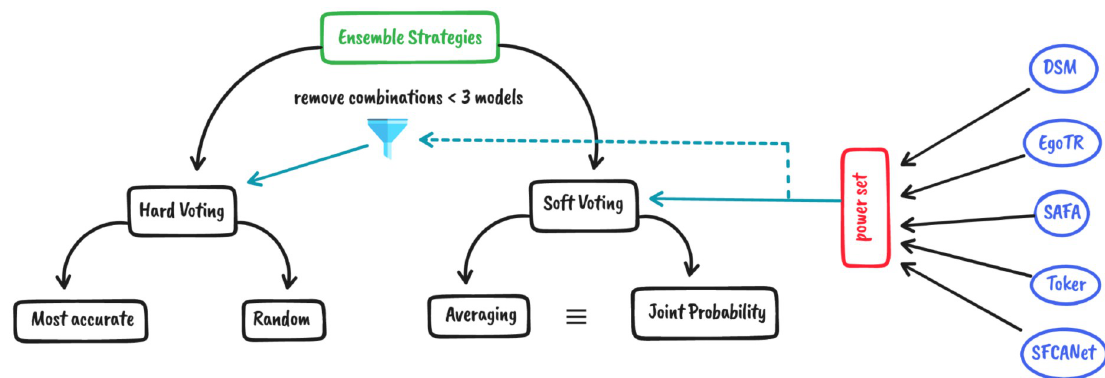
Fig 1. Different ensemble aggregation methods.